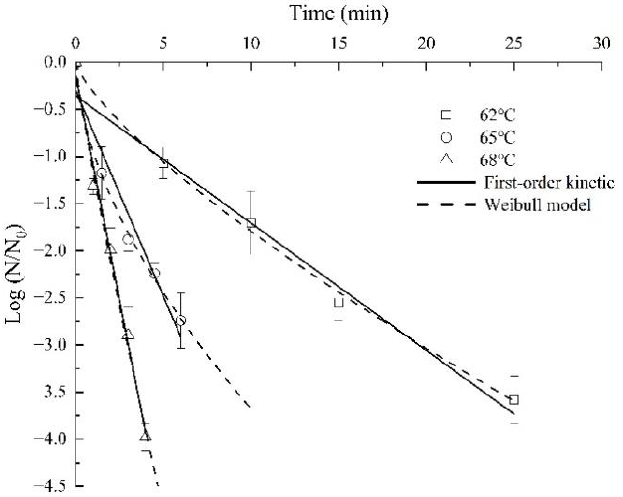
Figure 4. The target Aspergillus inactivation from the first-order kinetic and the Weibull models affected by temperature under a w of 0.854.